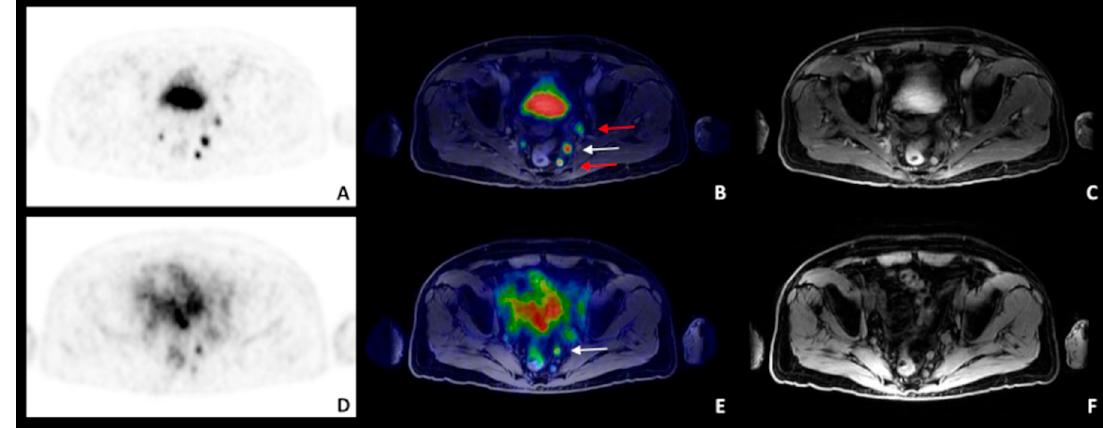
Figure 3. A 75 years-old patient with biopsy-proven PCa (patient n. 3), Gleason score 9 (4 + 5) with a PSA level at diagnosis of 4.73 ng/mL. 68 Ga-PSMA and 68 Ga-DOTA-RM2 PET/MRI were discordant in detecting lymphnodal metastases. 68 Ga- PSMA PET/MRI (top panel; ( A ): transaxial 68 Ga-PSMA PET; ( B ): 68 Ga-PSMA PET/MRI; ( C ): post-contrast Water Lava-Flex sequence) showed bilateral pararectal and left external iliac lymphnodal uptake; 68 Ga-DOTA-RM2 PET/MRI (bottom panel; ( D ): transaxial 68 Ga-DOTA-RM2 PET; ( E ): 68 Ga-DOTA-RM2 PET/MRI; ( F ): Water-Lava Flex sequence) showed left pararectal and left external iliac lymphnodal uptake. White arrow indicates the lymph node clearly detected by both tracers; red arrows lymph nodes detected by 68 Ga-PSMA PET/MRI only.